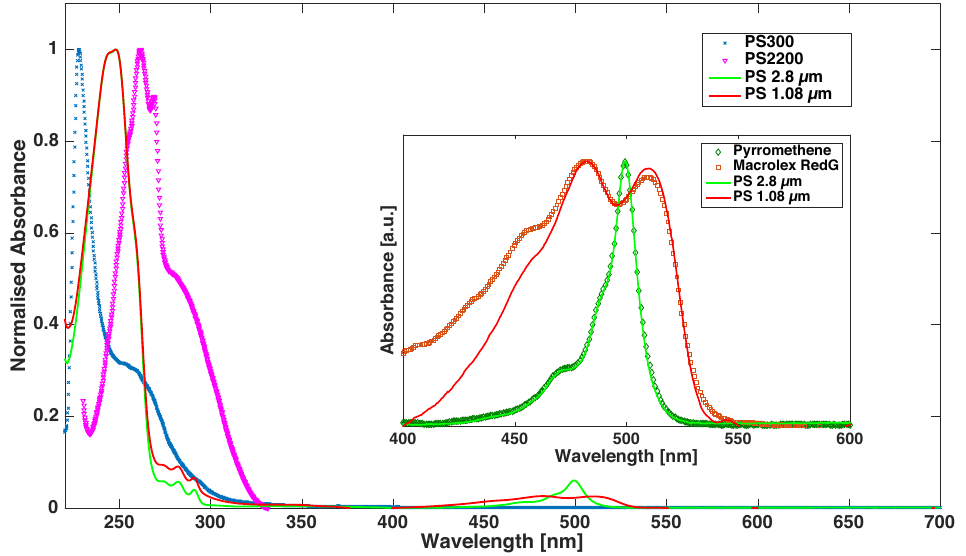
Figure 4. UV-Vis spectra of supernatants after overnight exposure to decane for the 2.8 ( green solid line) and 1.08 µ m ( red solid line) diameter PS particles. The spectra are combined with the UV-Vis spectra of reference decane solutions of pure PS (molecular weight 300 Da ( blue crosses) and 2200 Da ( purple triangles)) and of the red (Macrolex RedG ( red squares)) and green (Pyrromethene ( green diamonds)) dyes, zoomed in the inset for the relevant wavelength